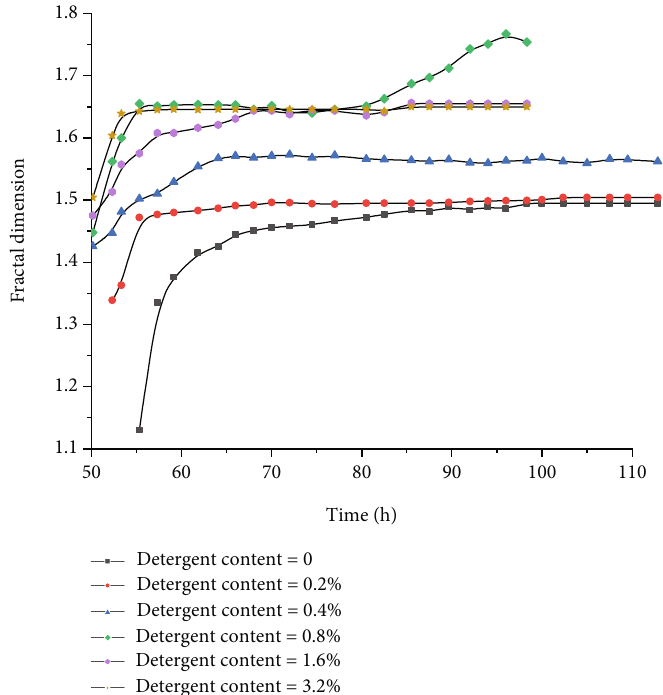
Figure 9: Changes in fractal dimensions of fracture with